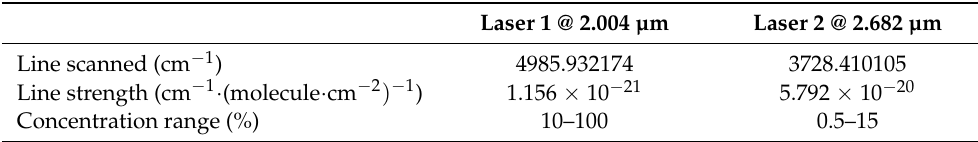
Table 1. The rovibrational transition positions in wavenumber with their absorption strength and concentration range under standard tasting conditions for both